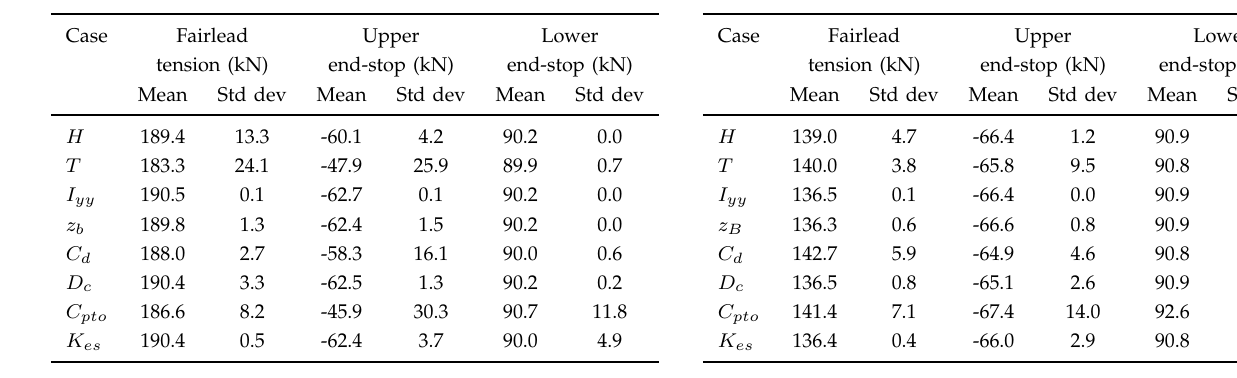
TENSION , UPPER AND LOWER END - STOP FORCES FOR THE ERW2 CASE USING d = 1 .